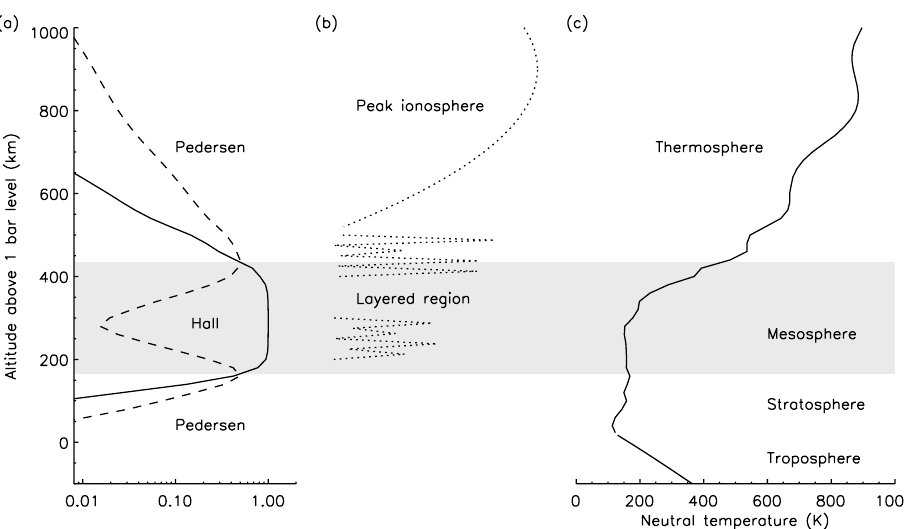
Fig. 2. Schematic of the conducting properties of Jupiter’s atmosphere. (a) The functions in square brackets in Eqs. (1) and (2), representing the importance of Pedersen (dashed line) and Hall (solid line) conductivities. The shading shows the “Hall region” in which Hall conductivity is more important than Pedersen conductivity. At the upper boundary of the shaded region r i = 1 and at the lower boundary r e = 1. (b) Schematic of the ionospheric electron density structure. (c) Atmospheric temperature profile from the Galileo probe (Seiff et al.,